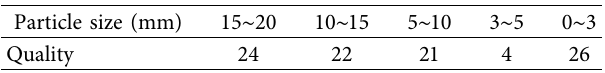
Table 2: AC-20 asphalt concrete mix ratio (kg).